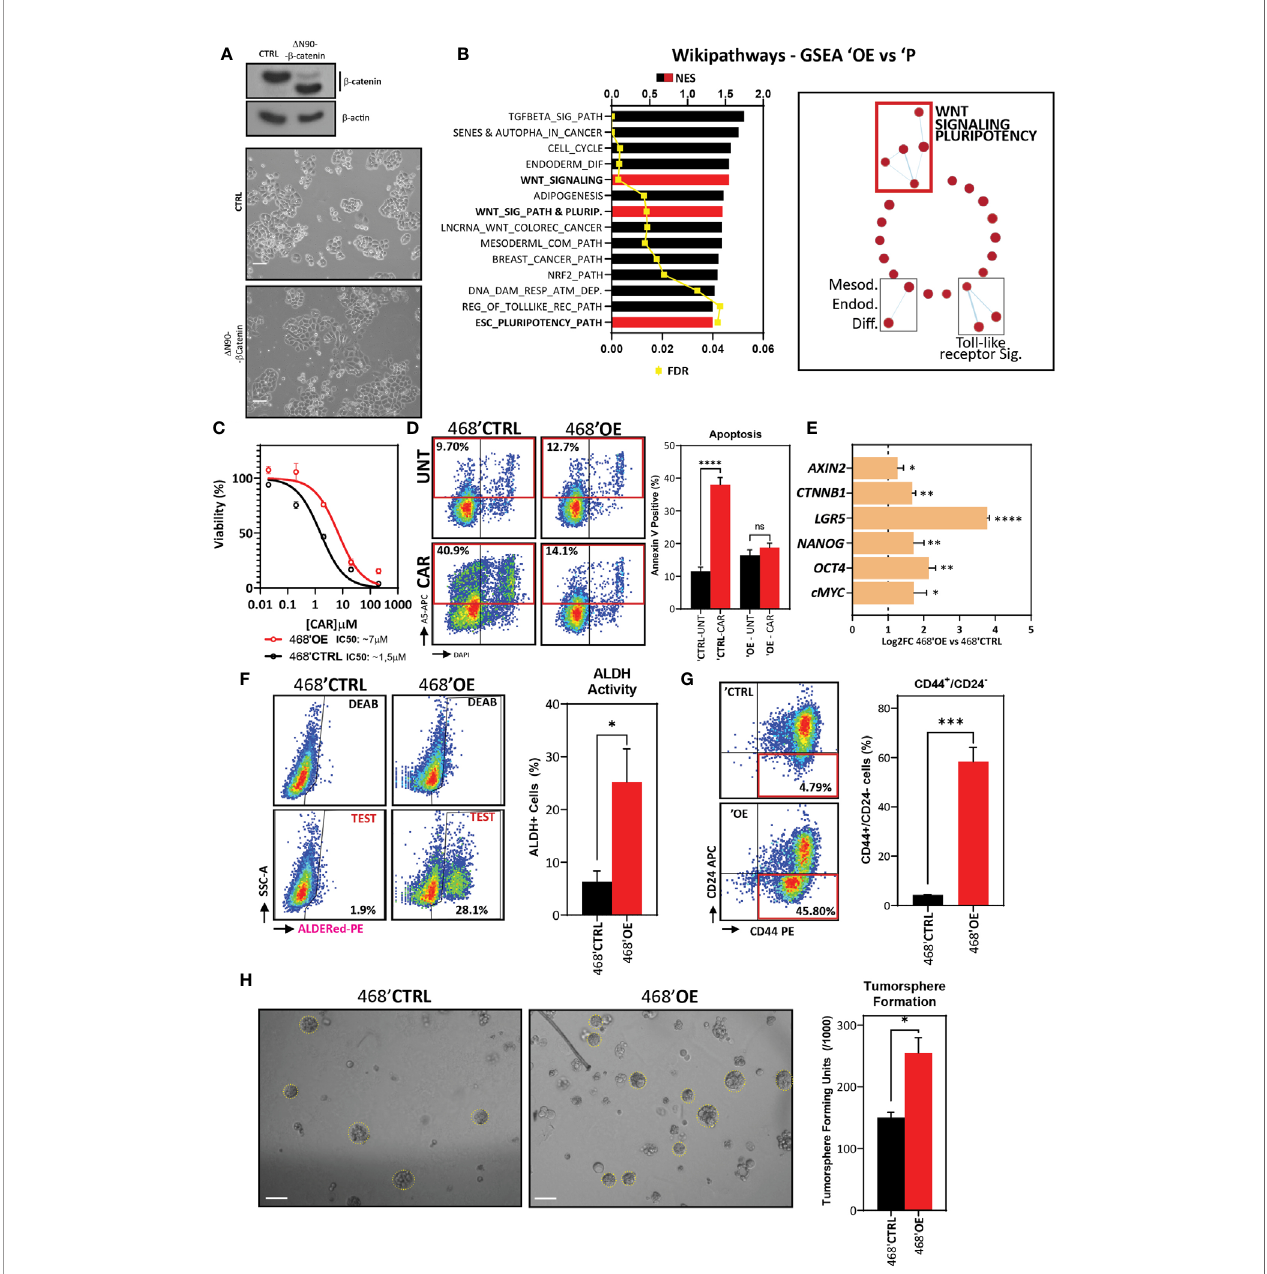
FIGURE 3 | b -catenin overexpression in 468 ’ P induces carboplatin-resistance, pluripotency-related gene expression, and cancer stem cell features. (A) Western blot (top) of total b -catenin in MDA-MB-468 cells transduced with an empty vector or truncated, constitutively active b -catenin isoform D N90 and phase-contrast microscopy (down). (B) Enriched gene sets from Wikipathways database by one-tailed GSEA of ranked DEGs between 468 ’ OE and 468 ’ P sorted by normalized enrichment score (left) and enrichment map illustrating pathways most signi fi cantly different between 468 ’ OE and 468 ’ P (right). (C) Non-linear fi t model of [CAR] vs . normalized response for IC50 determination. (468 ’ OE: n=6, R 2 = 0.92; 468 ’ CTRL: n=6, R 2 = 0.95). (D) Representative fl ow cytometry scatterplots of annexin V staining (left) of 468 ’ CTRL and 468 ’ OE cells treated with carboplatin 2 m M for 72h and statistical analysis of the mean frequency of annexin V positive cells using one-way ANOVA corrected for multiple comparisons using the Holm-Sidak method (right, n=3). (E) mRNA level fold change (Log2) of CTNNB1 ( b -catenin), Wnt target AXIN2, and stem cell markers in 468 ’ OE cells vs . 468 ’ CTRL (n=4). Multiple t-tests with Holms-Sidak correction for multiple comparisons. (F) Representative scatterplots of fl ow cytometric analysis of aldehyde dehydrogenase activity (left) and statistical analysis of the mean percentage of ALDH+ cells in 468 ’ OE (n=5) and 468 ’ CTRL (n=5) using Welch ’ s t-test (right). (G) Representative scatterplots of fl ow cytometric analysis of CD44-PE and CD24-APC immunolabeling (left) and corresponding statistical analysis of the mean percentage of CD44 + /CD24 - cells using Welch ’ s t-test (right; n=3). (H) Representative bright fi eld images of tumorspheres generated from 468 ’ CTRL and 468 ’ OE cells (left, scale bar: 50 m m) and statistical analysis of mean tumorsphere forming units (number of spheres/number of seeded single cells) using Welch ’ s t-test (right; n=3). (Barplots represent mean + SEM. *p < 0.05; **p < 0.01; ***p < 0.001; ****p < 0.0001; ns, non signi fi